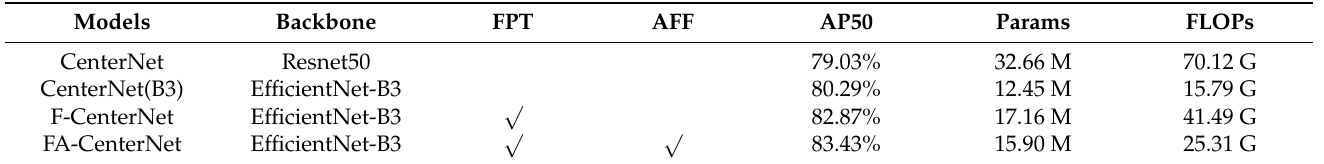
Table 3. Ablation experiment